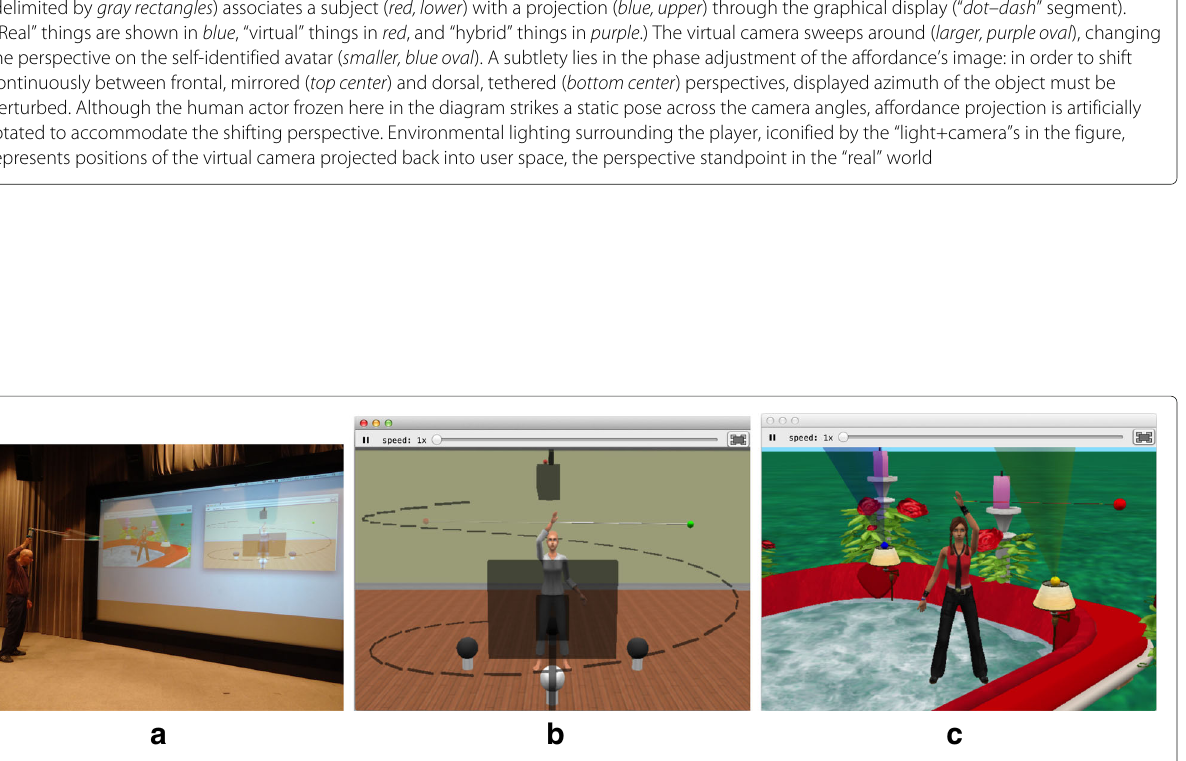
Fig. 19 Juxtaposed alternate projections of poi twirler: Parameterizing avatar handedness and twirling prop phase by virtual camera position lessens cognitive load of mentally reflecting projection of a self-identified avatar or that of a spun or whirled affordance, even while a free-viewpoint virtual camera swings around. An affordance held in user’s right hand is instantaneously pointing to user’s right, but the camera-conscious mixed virtuality avatar shifts it to the contralateral (opposite) hand as projected affordance phase is perturbed to flatter frontal perspective. (“Order” in the subfigure captions refers to those mentioned by Table 1) a 0 th -order (“real life”) scene, with poi -twirling user observing both 2 nd - and 1 st -order projections b 1 st -order, 3 rd -personscene, showingactualaffordanceposition ( translucent,red-capped ), anticipated perturbed projection ( opaque,green-capped ), orbital virtual camera (translucent), unwrapped spin-around phase (dashed helical camera tail stream, 1 1 / 2 revolutions from initial dorsal position) connected to graphic monitor (translucently glazed), and simulation of environmental lighting (frontal light illuminated). c 2 nd -order, 2 nd -person mixed-virtuality fantasy scene with ambidextrous avatar and affordance projection perturbation. A right-handed user appreciates mirrored projection of a frontal perspective, since it visually aligns and therefore seems more natural than a faithful, chirality-preserving